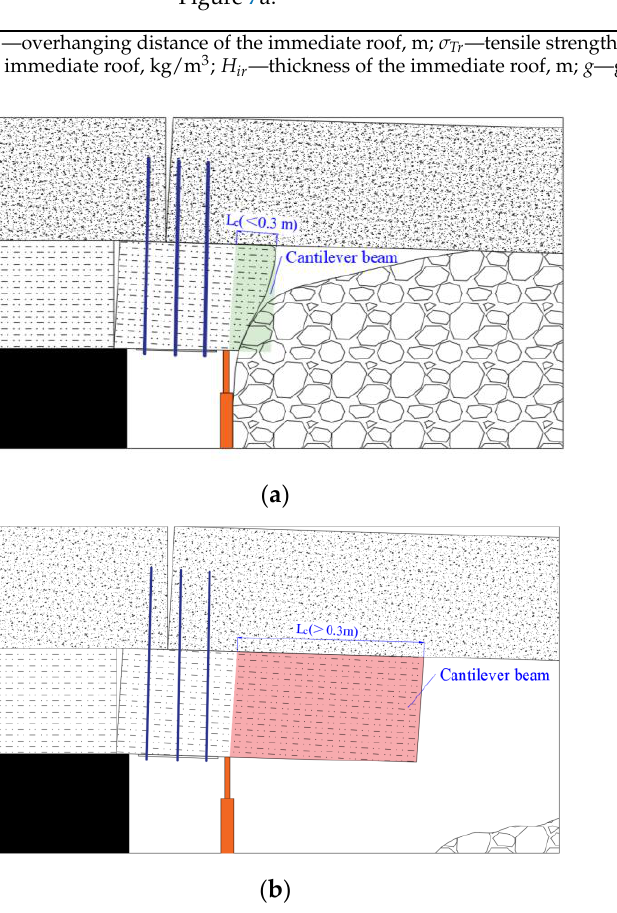
Figure 7. Determination of immediate roof cavability. ( a ) The cantilever length is smaller, the immediate roof will fall. ( b ) The cantilever length is greater, the immediate roof will become an overhanging roof.